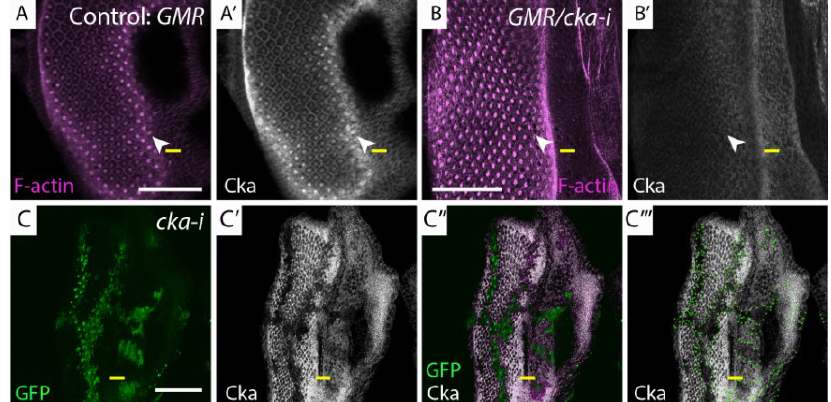
Figure A1. Validation of cka-i . ( A – C ) Planar sections of larval eye discs. Yellow line indicates morphogenetic furrow. White scale bar represents 50 µM. ( A , A' ) Control; GMR eye disc stained with F-actin and Cka revealing the apical surface of eye disc; ( B , B' ) GMR/cka-i eye disc stained with F-actin and Cka, note apical depletion of Cka staining posterior to the morphogenetic furrow; ( C , C' ) cka-i clones (GFP tissue) show depletion of Cka staining (white); ( C" , C''' ) overlay of GFP positive tissue and Cka staining confirms lack of Cka staining in clones expressing cka-i (pink), cka-i clone boundaries outlined with green dots. ( A ) Control: GMR: GMR-GAL4/+ ; ( B ) GMR/cka-i : GMR-GAL4/UAS-cka-RNAi 1 ° 6971 ; ( C ) cka-i : eyFLP , UAS-GFP ; gal80 , FRT40/UAS-cka-RNAi 1 ° 6971 , FRT40 ; tubgal4/+